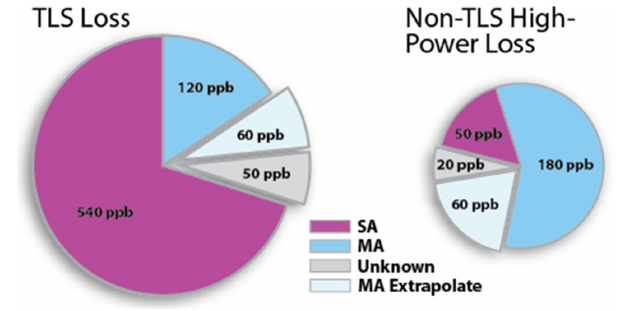
FIG. 8. The localization of 93% of both the TLS and the non-TLS loss through selective etching. The loss reduction in standard resonators due to SA etching (magenta) and MA etching (blue). The projected loss reduction from complete MA-oxide removal (light blue) extrapolated from fits in Fig. 7(c). The non- localized loss (unknown, in gray) includes contributions from the MS interface, the regrown SA oxide, and loss associated with bulk Si and Nb. The pie areas represent δ TLS and δ hi in parts per billion